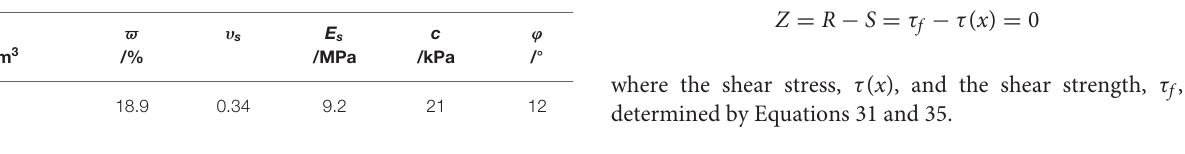
TABLE 1 | Physical mechanical parameters of soil.